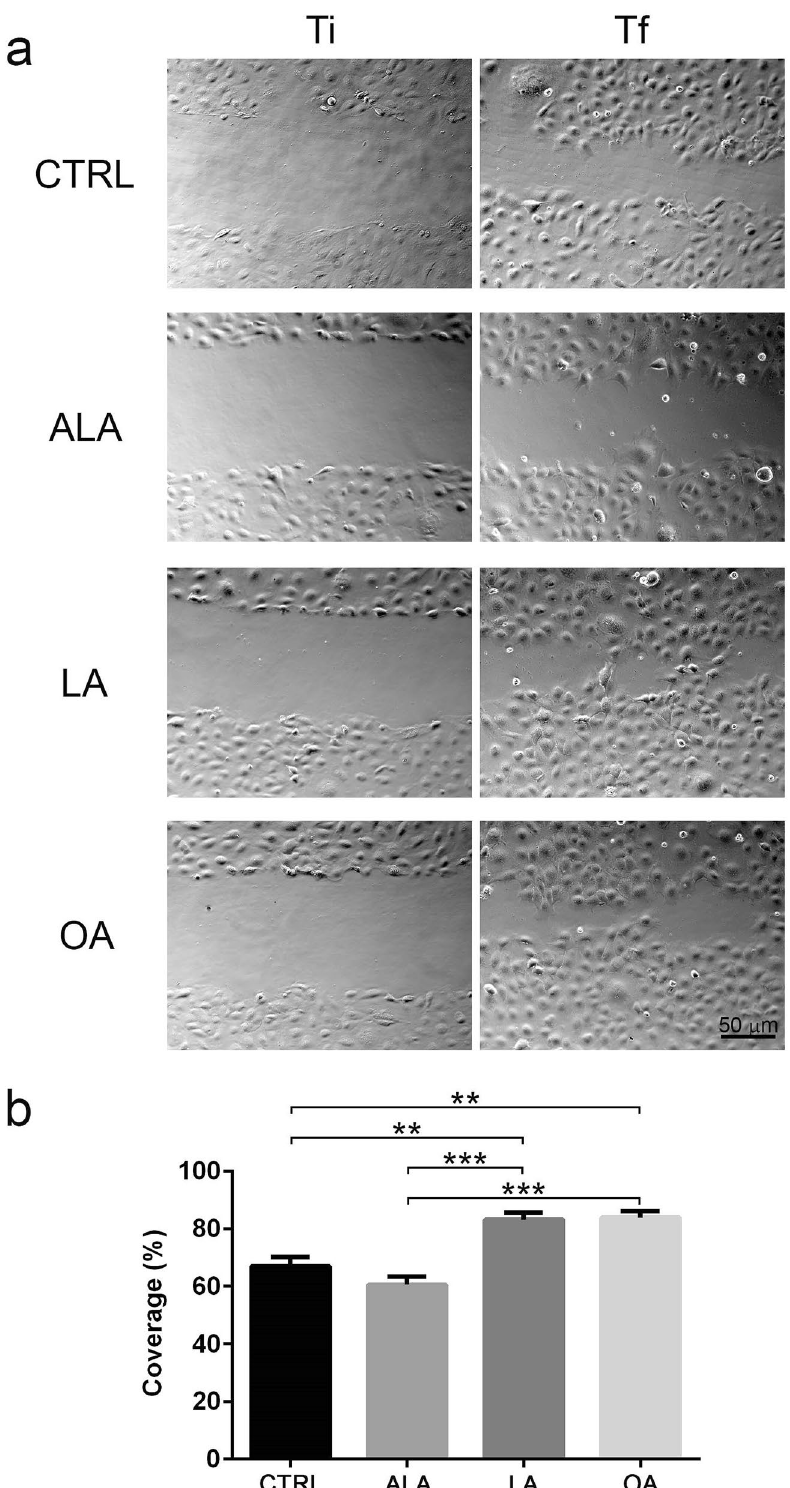
Figure 1. LA and OA promoted SKOV-3 cell migration in an in vitro wound-healing assay. ( a ) Phase microscopy of the scratch zone within the first 2 h after scratch (Ti) or at 24 h after the scratch (Tf) for treatment with serum free media containing ethanol (control), ALA, LA or OA. ( b ) Relative coverage of the wound area expressed as percentages. Graph shows mean ± SEM of 10 photographs per condition in 4 independent experiments. Asterisks represent statistical significance using Kruskal–Wallis test with Dunn’s multiple comparisons (**p < 0.01, ***p < 0.001). Scale bar 50